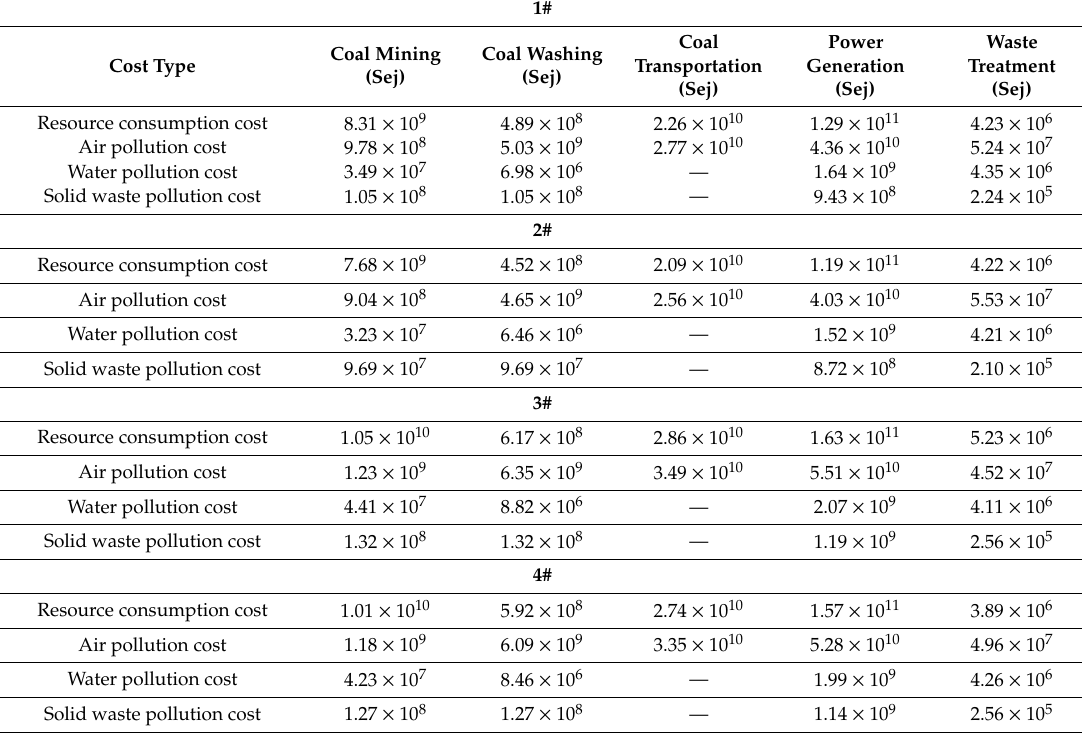
Figure 5. Socio-economic investment of waste treatment stage. Table 9. Life cycle socio-economic investment for four power generation units.